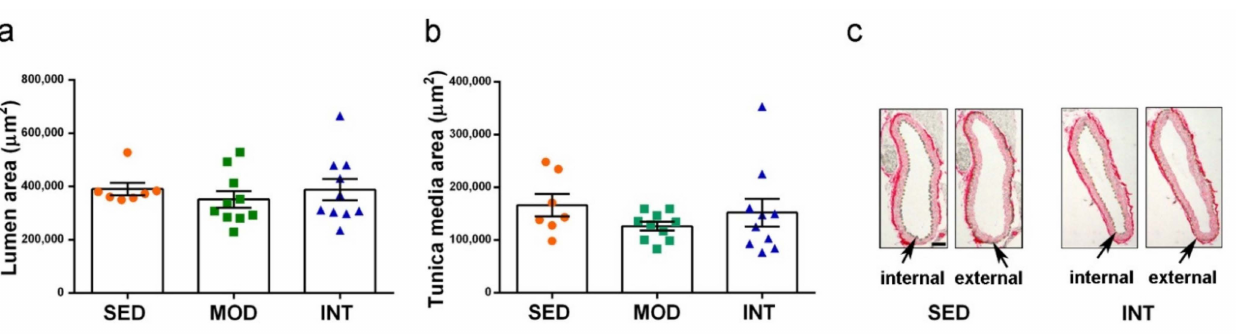
Figure 4. Exercise training did not induce gross morphological changes in the aorta. ( a ) Area of the aorta lumen; ( b ) area of a transversal section of the tunica media; ( c ) representative histological images of the aorta section with arrows pointing to dots indicating the internal and external limit of the tunica media. Experimental groups: SED (orange circles), sedentary; MOD (green squares), moderate training; INT (blue triangles), high-intensity training. Values are mean ± SEM (( a , b ) SED n = 7, MOD n = 10, INT n = 10). Scale bar = 100 µ m in ( c